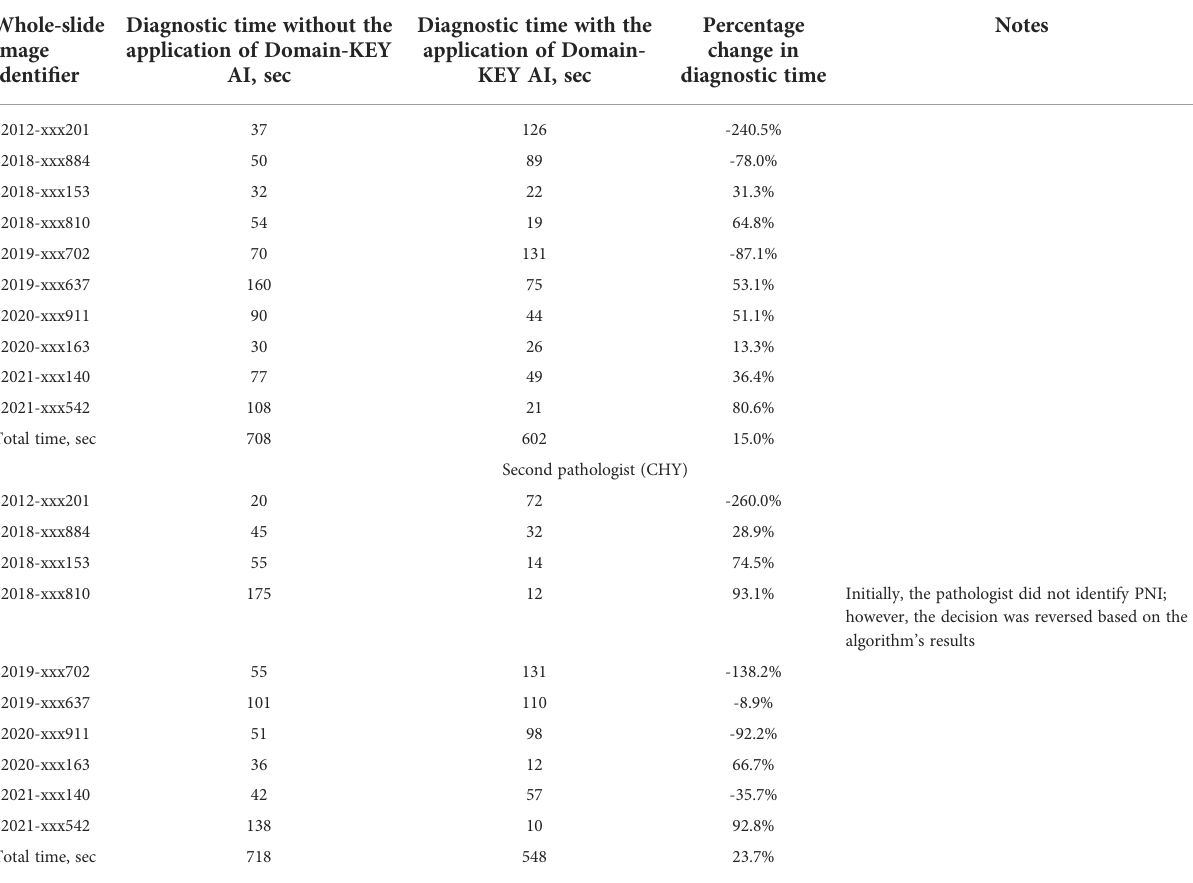
TABLE 6 Impact of the model in decreasing the time required to reach a diagnosis: analysis of whole-slide images. First pathologist